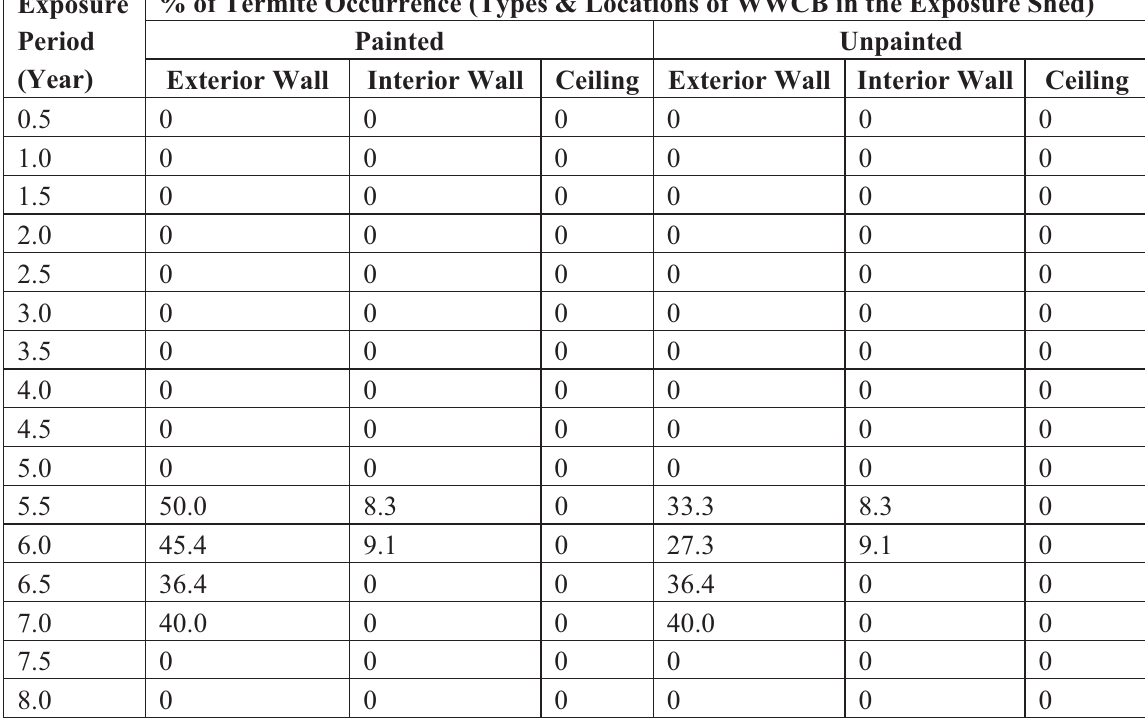
Table 3. Progress in termite incidence on the WWCBs in outdoor exposure